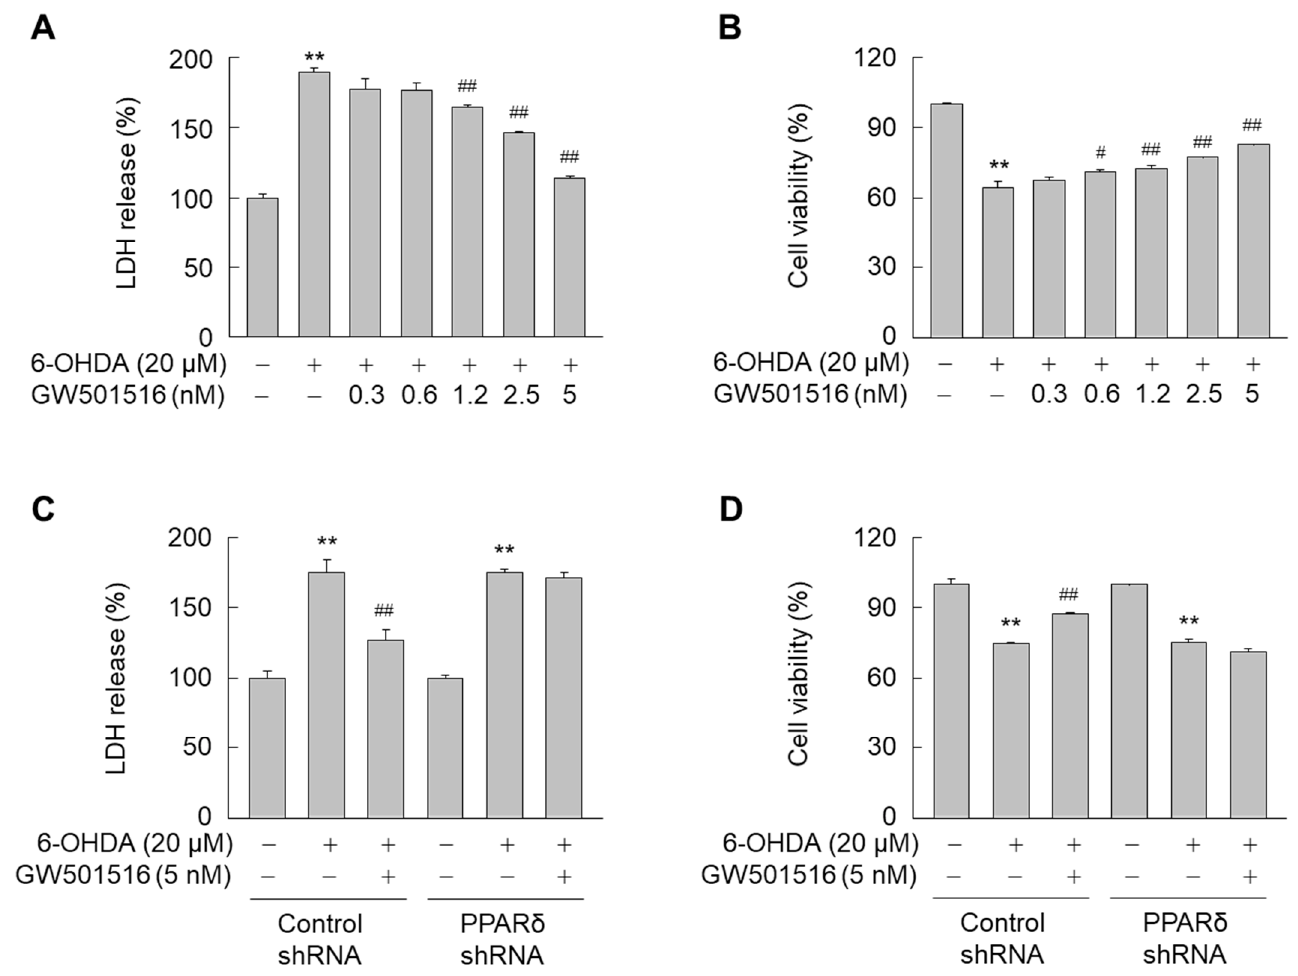
Figure 1. GW501516 PPAR δ activation inhibits 6-OHDA-induced neurotoxicity in SH-SY5Y cells. ( A , B ) Cells pretreated with increasing concentrations of GW501516 for 8 h were exposed to 6-OHDA. After incubation for 24 h, LDH release ( A ) and MTT assays ( B ) were performed to evaluate 6-OHDA-induced cellular damage. ( C , D ) Cells stably expressing shRNA targeting scrambled sequences or PPAR δ were pretreated with vehicle (DMSO) or GW501516 for 8 h and subsequently exposed to 6-OHDA. Following incubation for 24 h, cells were subjected to LDH release ( C ) and MTT assays ( D ). Results are expressed as means ± SE ( n = 3). ** p < 0.01 relative to untreated group; # p < 0.05, ## p < 0.01 relative to 6-OHDA-treated group.